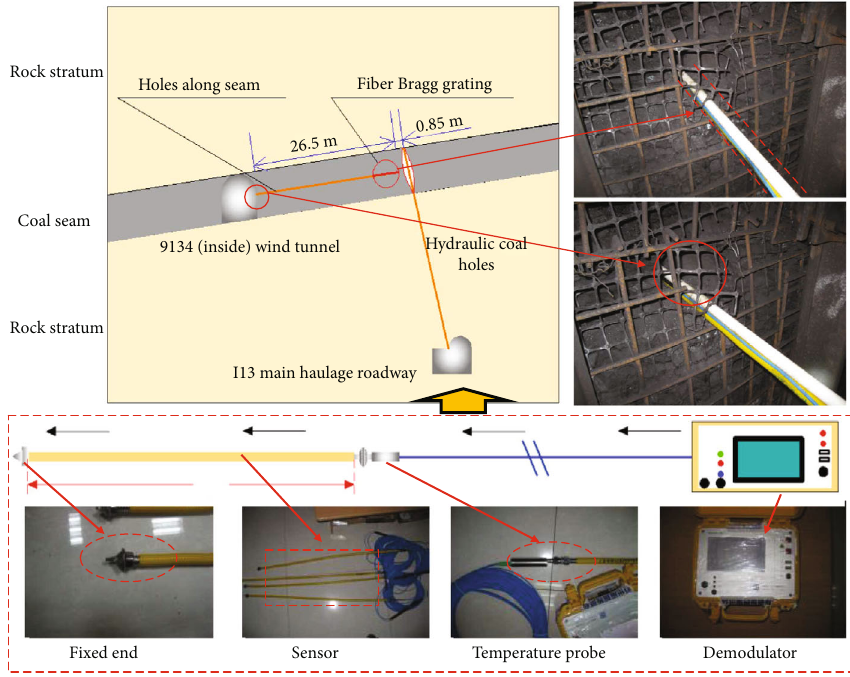
Figure 9: Layout of the fi ber grating and fi ber grating experimental